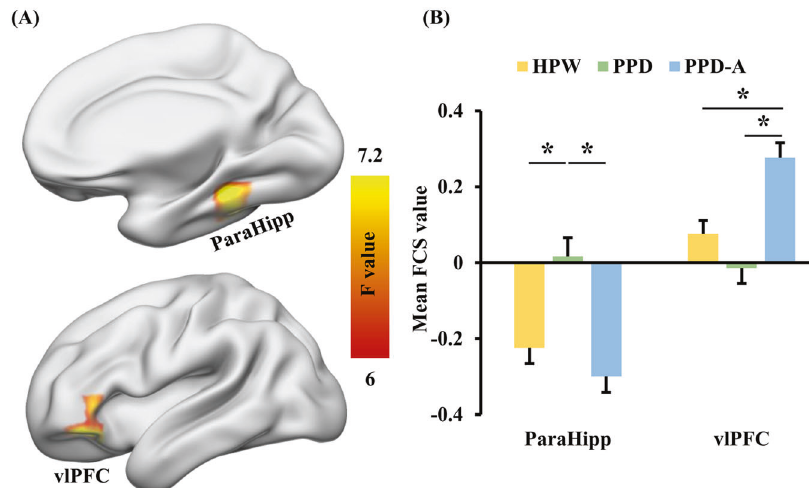
Fig. 1 Functional Connectivity Strength (FCS) differences among HPW, PPD, and PPD-A. A One-way analysis of variance (ANOVA) of functional connectivity strength (FCS) maps revealed signi fi cant differences in right parahippocampus (ParaHipp) and left ventrolateral prefrontal cortex (vlPFC) between postpartum depression (PPD) and PPD with anxiety (PPD-A) and healthy postnatal women (HPW). B Post- hoc two-sample t tests showed that FCS in ParaHipp was higher in PPD patients compared to PPD-A patients and HPW, and FCS was higher in vlPFC in PPD-A patients compared to both PPD patients and